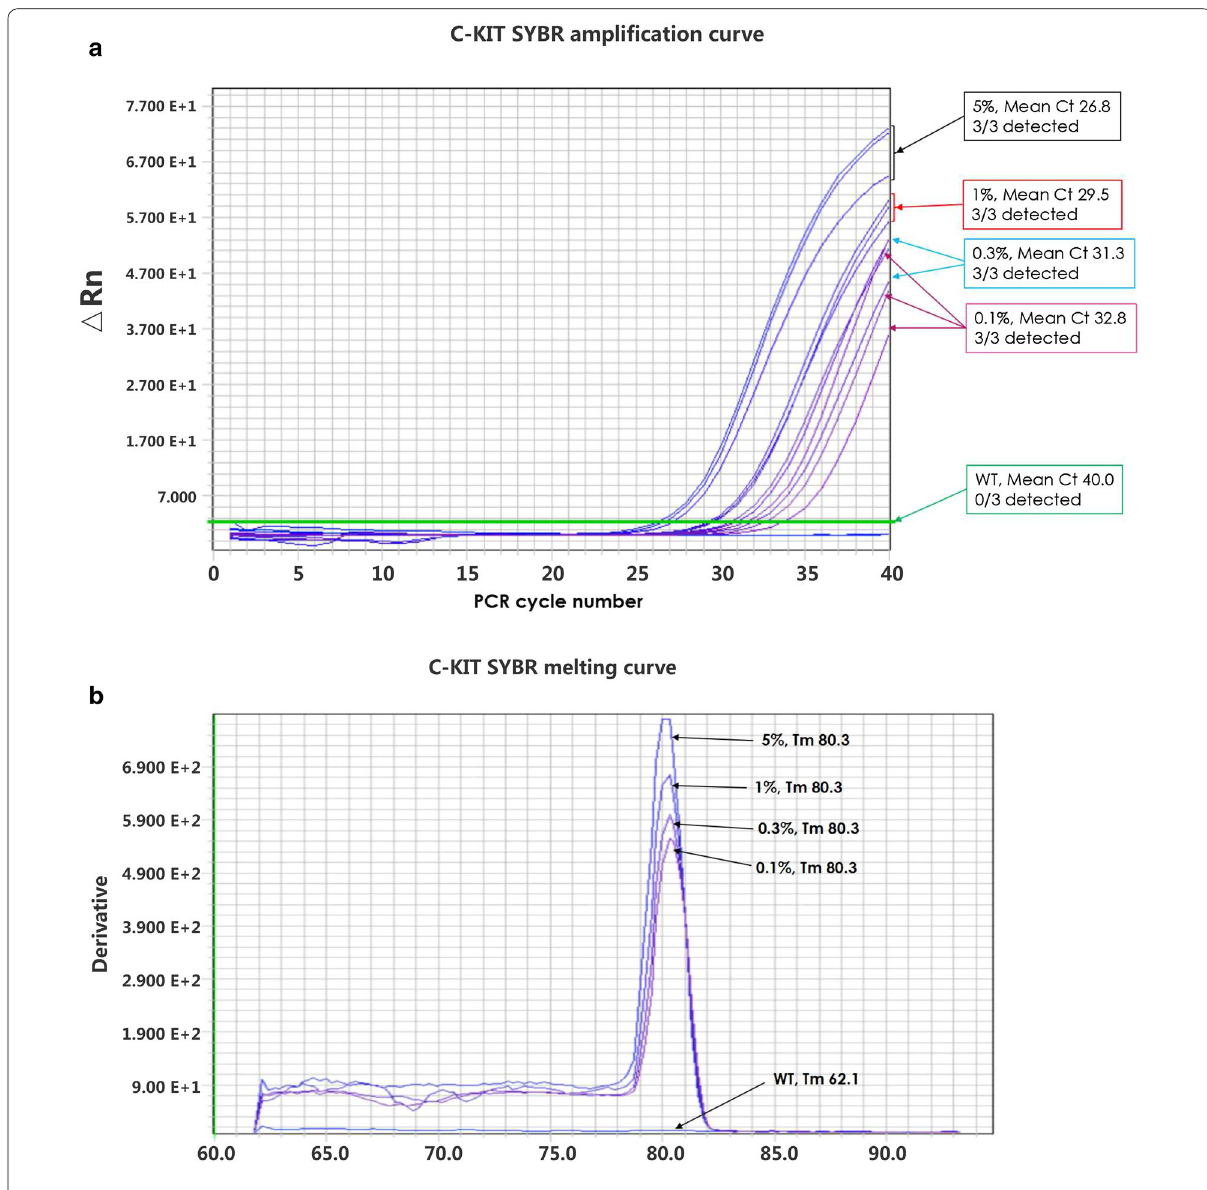
Fig. 5 QClamp ™ assay for KIT exon 17 D816V/Y/H mutation detection performed with template DNA containing D816V mutations at the